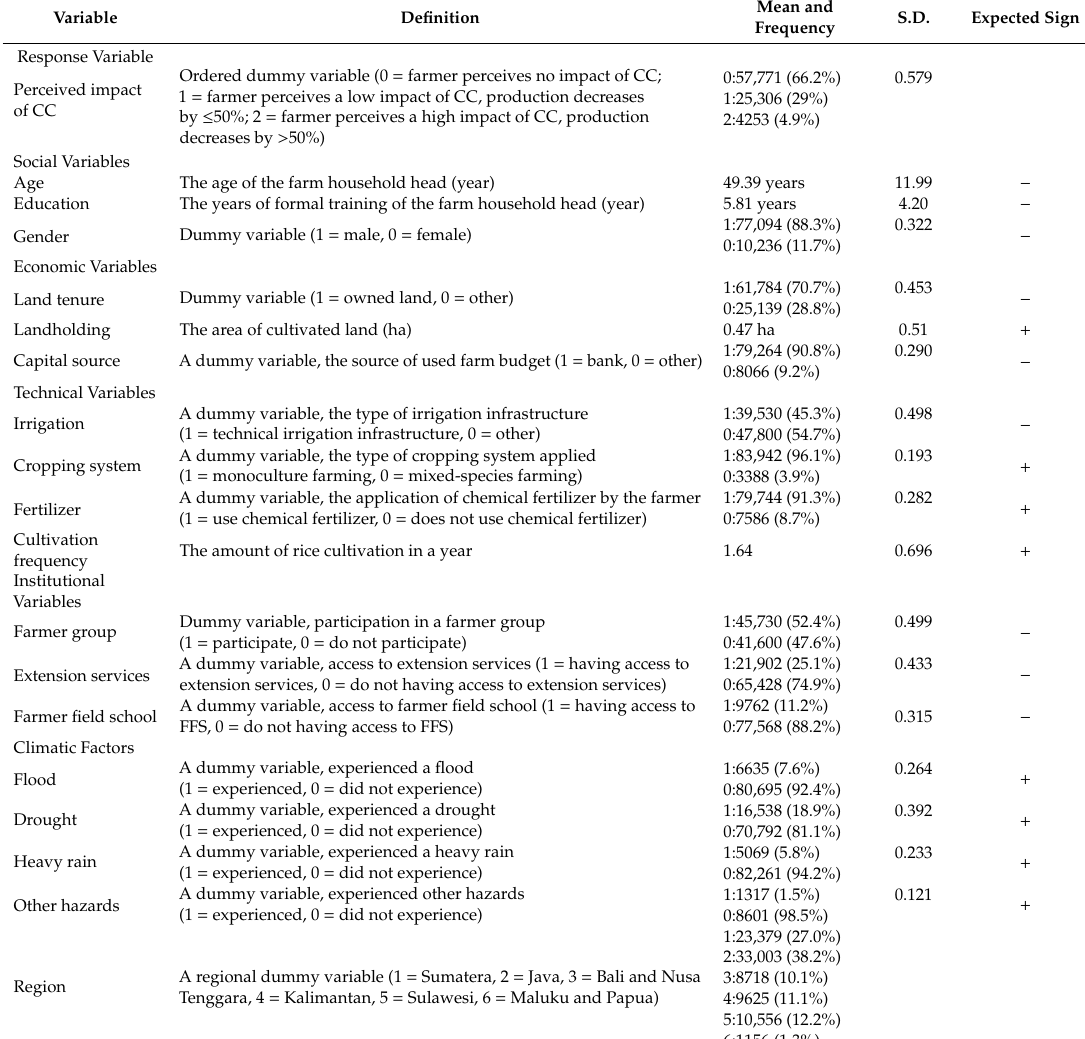
Mean and Frequency